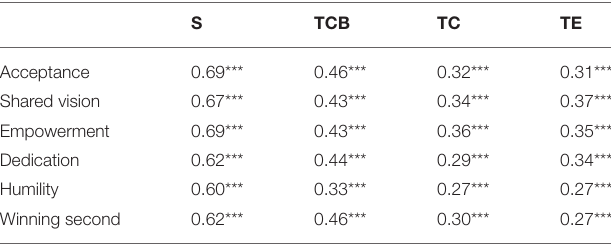
TABLE 6 | Correlations between coaching servant leadership and outcome